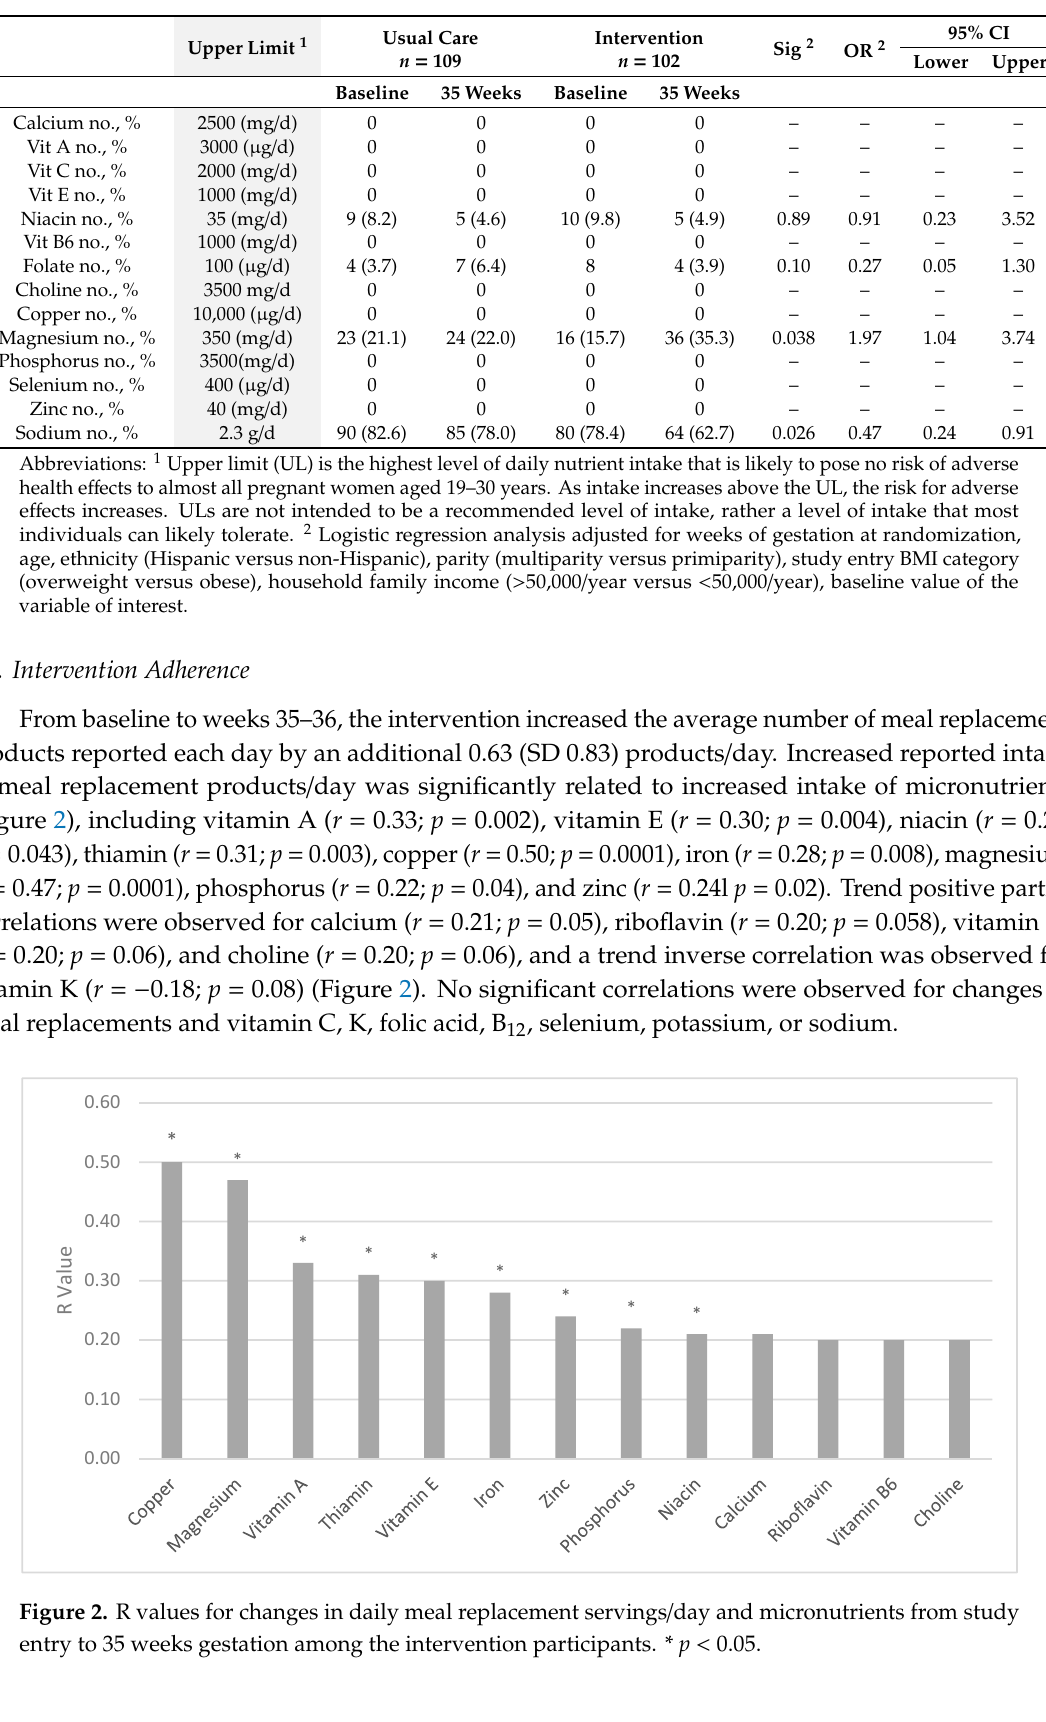
Table 5. Proportions with micronutrient levels above recommended tolerable limits.